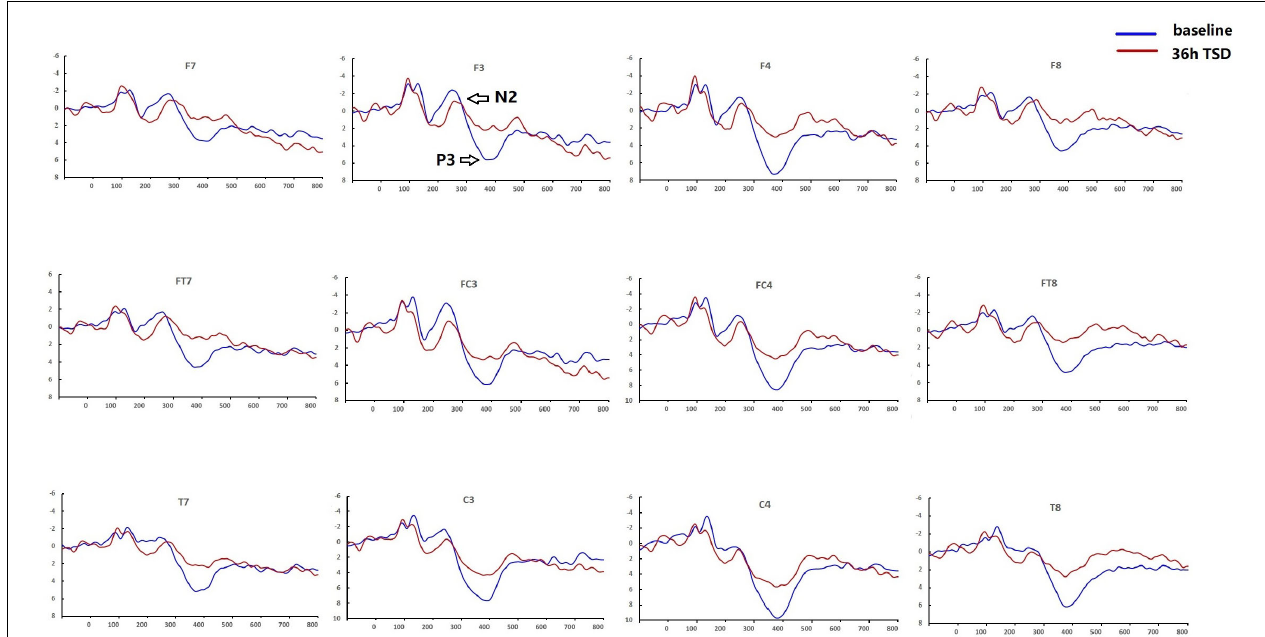
FIGURE 3 | Comparison of ERP amplitude and latency between baseline and 36-h TSD for the correct response in working memory. The channels are ordered left-right and top-bottom as follows: F7, F3, F4, F8, FT7, FC3, FC4, FT8, T7, C3, C4, T8.